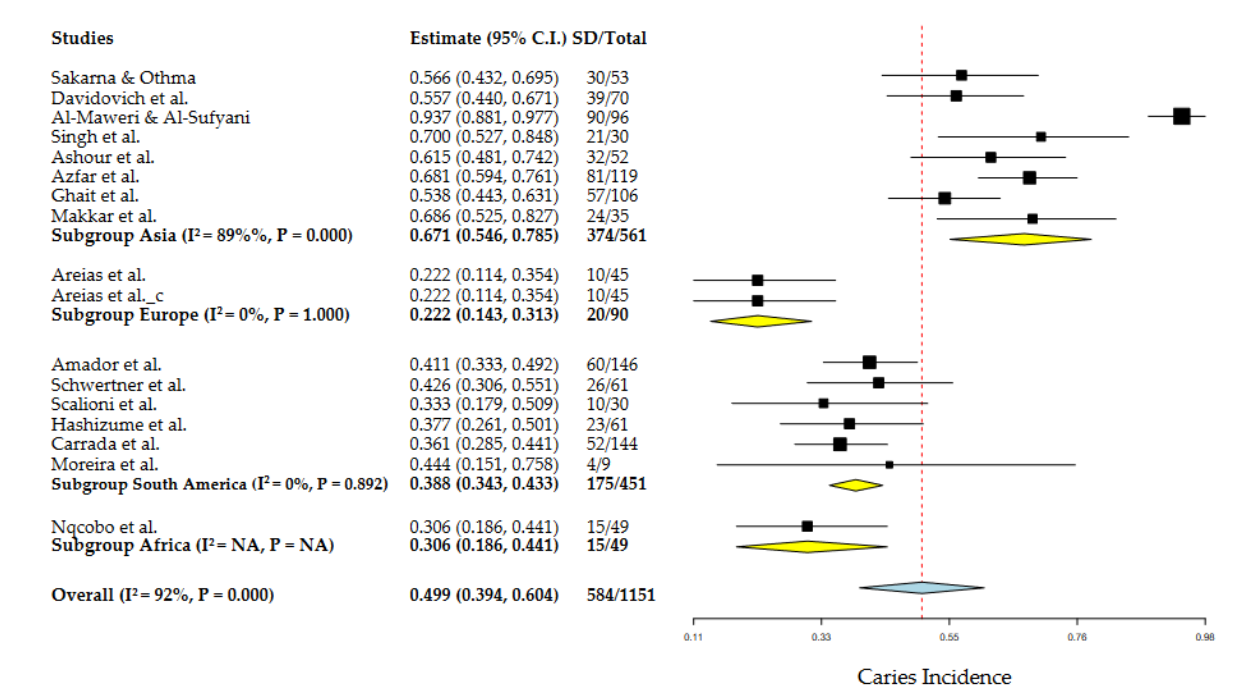
Figure 5. Geographic subgroup meta-analysis (Asia, Europe, South America and Africa) of caries incidence in DS patients. Articles references (from top to bottom): Subgroup Asia [20,22,23,25,30,31,33,34], Subgroup Europe [24,26] and Subgroup Africa [36].